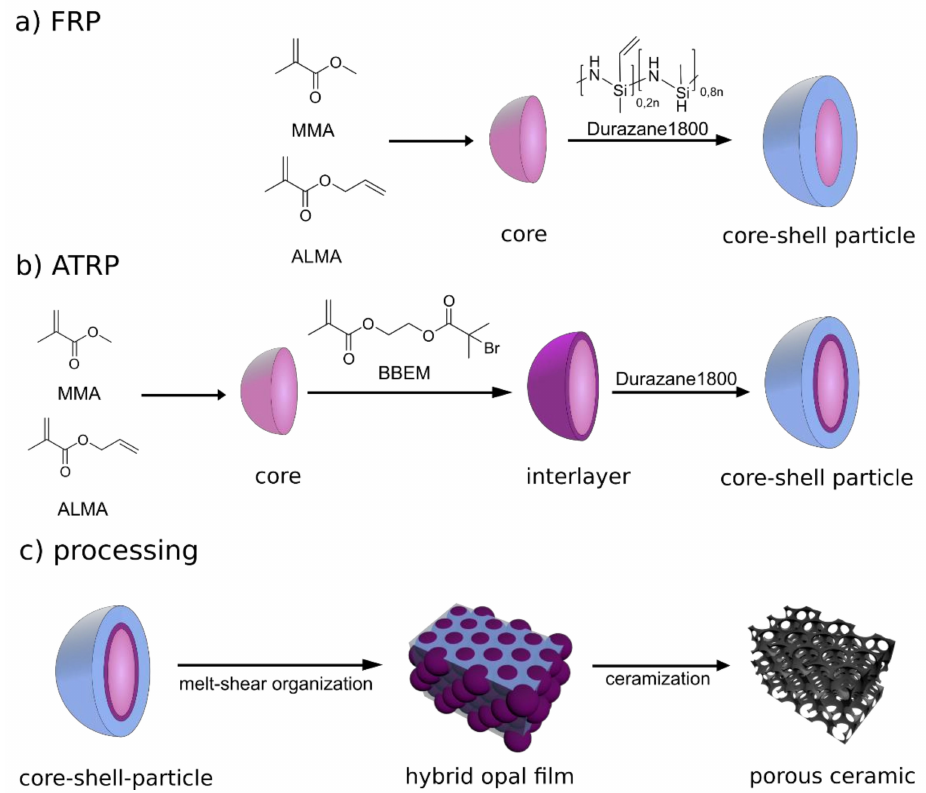
Figure2. Hybridorganic / inorganicpreceramiccore–shellparticlesynthesisviaemulsionpolymerization and FRP ( a ) / ATRP ( b ) and processing ( c ) into hybrid opal films through melt-shear organization, followed by thermal conversion into highly ordered porous SiCN